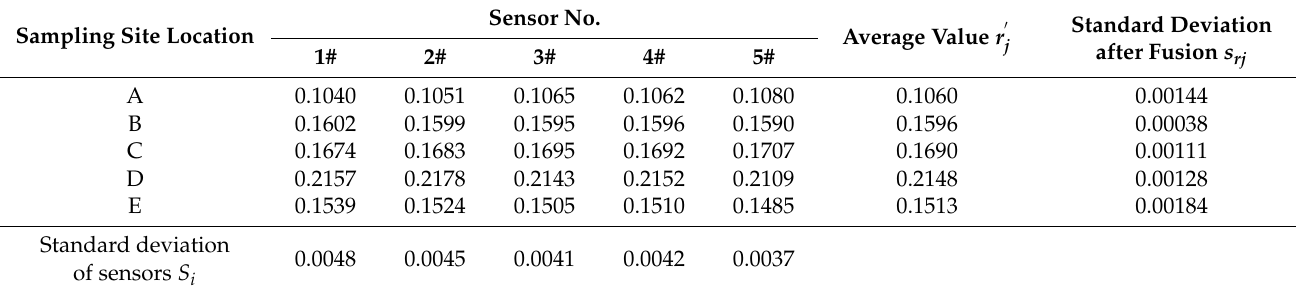
Table 4. List of the fusion results of the detection values of each sensor at different detection points (mm). Sampling Site